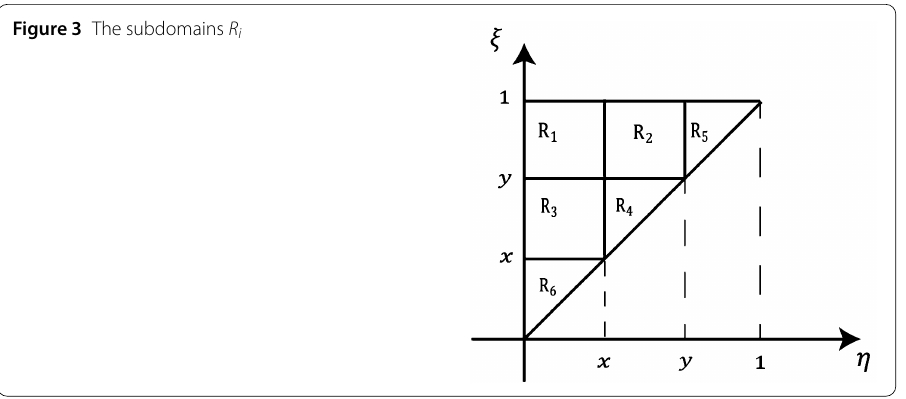
Figure 3 The subdomains R